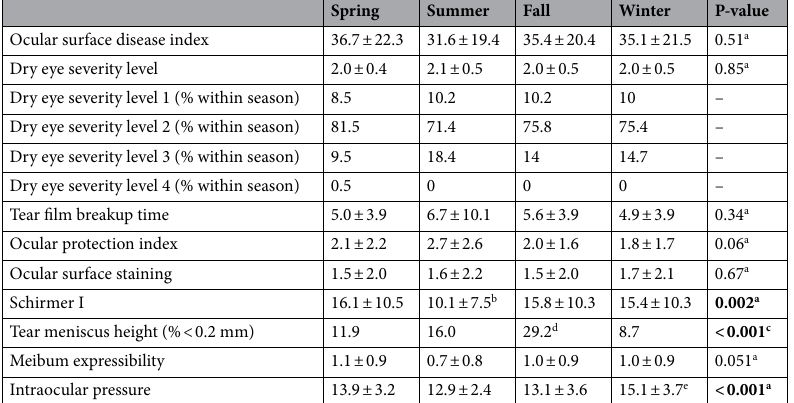
Table 4. Ocular symptoms and signs according to season. a One-way analysis of variance; b P < 0.01 compared to all other seasons (Tukey post hoc test); c Chi-square test; d higher percentage than expected ( P < 0.001; Chi- square test); e P < 0.05 compared to summer and fall (Tukey post hoc test); Bold font = statistically